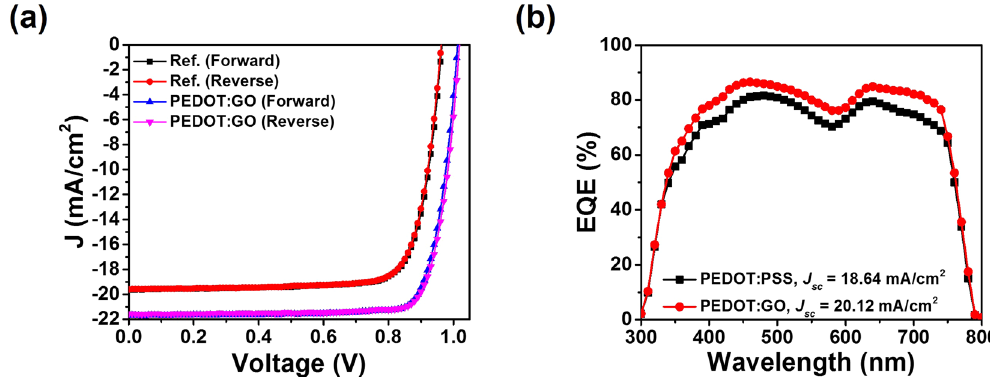
Figure 3. ( a ) J - V curves of the best-performing perovskite solar cells with PEDOT:PSS and a PEDOT:GO composite film under forward and reverse bias. ( b ) The external quantum efficiency (EQE) spectra of the best- performing